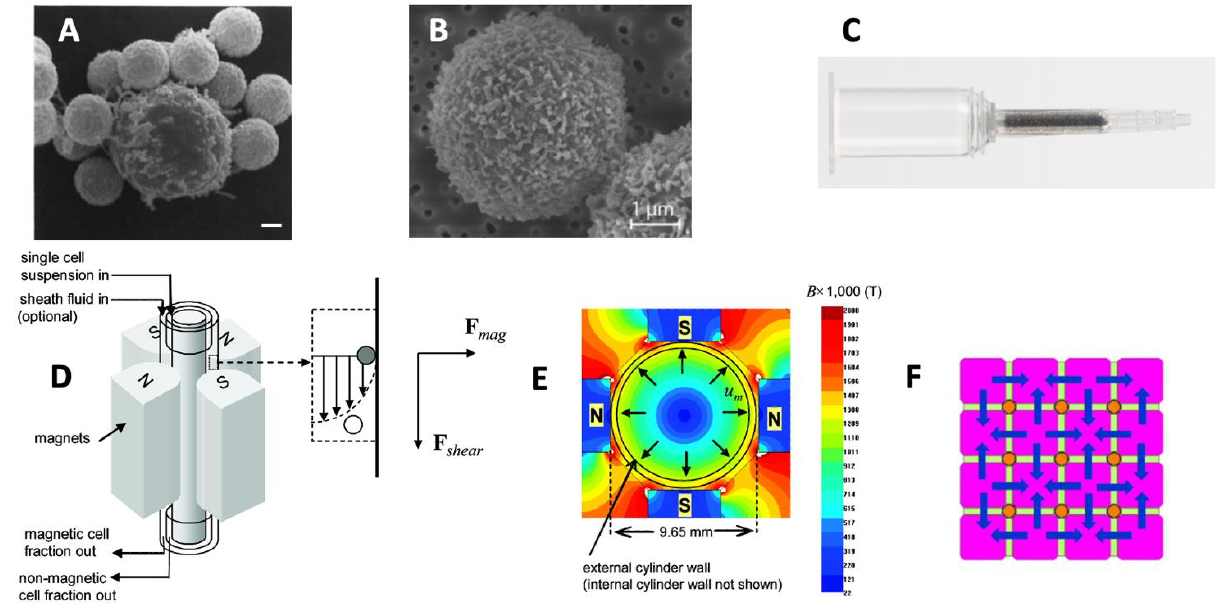
Figure 10. Examples of conventional magnetic particles and separators. ( A ) H9 lymphocyte infected with HIV-1 labeled with Dynabeads (2.8 µm in diameter) coated with anti-p-18 (scalebar: 1 µm). Reprinted with permission from [163]. ( B ) Human PBMCs labeled with MACS CD3 MicroBeads (50 nm) for the isolation of T cells (source: https://www.miltenyibiotec.com, accessed on 10 December 2021). ( C ) Example of dedicated column used with HGMS (source: https://www.miltenyibiotec.com, large cell column, accessed on 10 December 2021). ( D , E ) Schematics of a quadrupole magnetic cell sorter and corresponding magnetic field intensity in the radial direction. Adapted with permission from [6]. Copyright © 2011, American Chemical Society. ( F ) Tessellated permanent magnet circuits for flow-through, open-gradient cell separation (9-channel array). Light rectangles, pink areas and orange circles, respectively, represent permanent magnet blocks, soft steel yokes and flow channels. Adapted with permission from [162]. Copyright © 2016 Elsevier B.V.